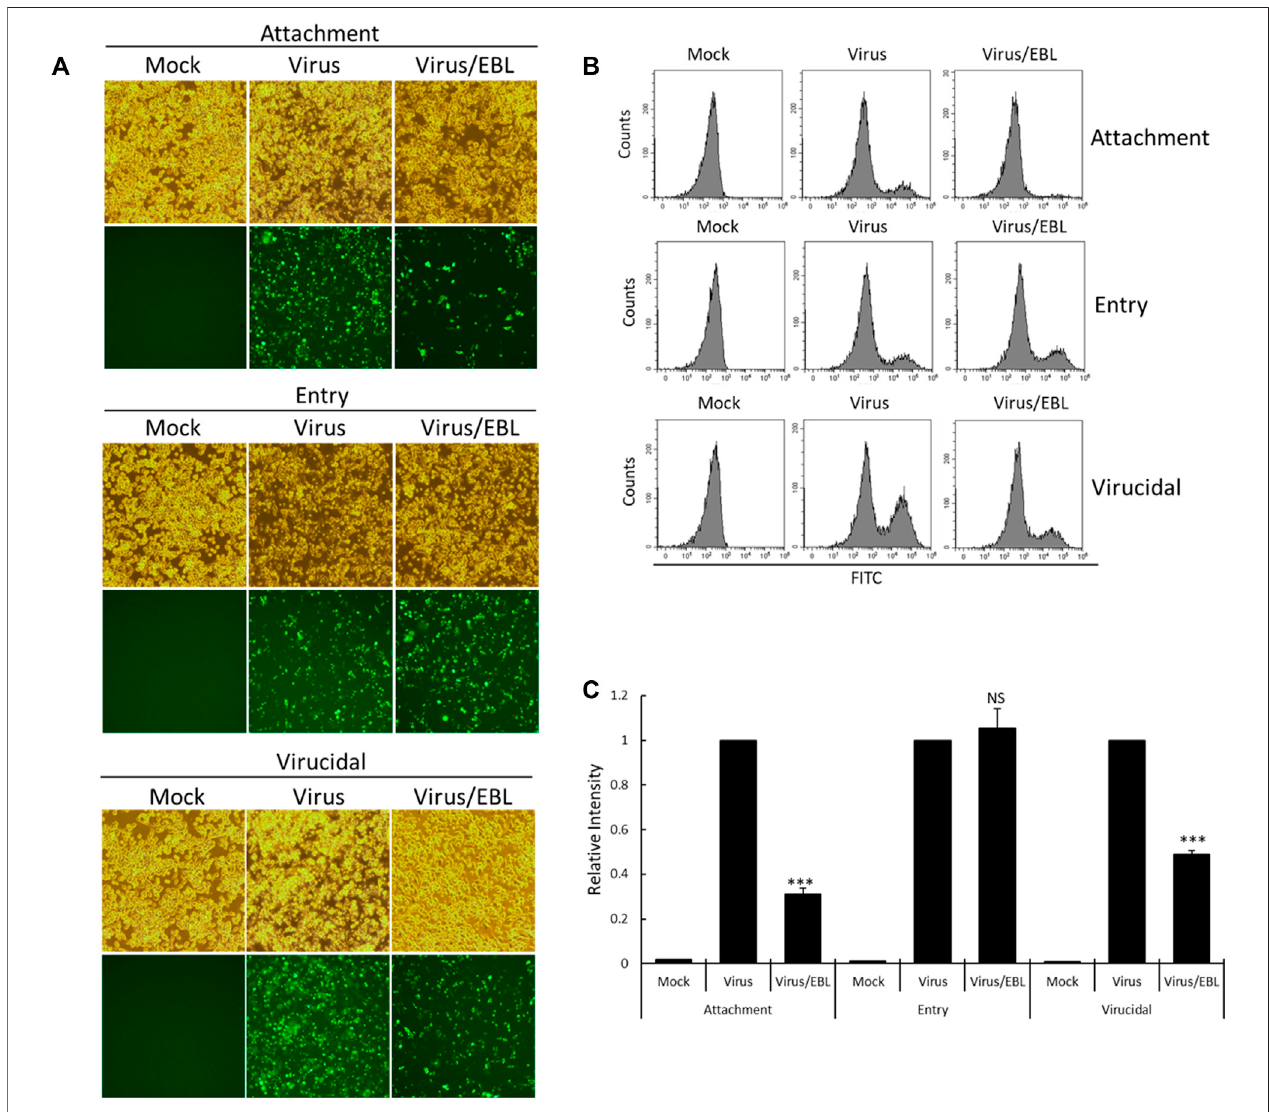
FIGURE4| EBLsuppressesviralattachmentandexertsavirucidaleffect. (A – C) Fortheattachmentstage,RAW264.7cellswerecotreatedwithPR8-GFPIAVand 200 μ g/mlEBLat4 ° Cfor30 min.Afterwashing,thecellswereincubatedat37 ° Cfor24 h.Fortheentrystage,thecellswereinfectedwithPR8-GFPIAVat4 ° Cfor30 min followed by the treatment of EBL at 37 ° C for 30 min. After washing, the cells were incubated at 37 ° C for 24 h. For the virucidal stage, PR8-GFP IAV and EBL were incubated at 4 ° C for 30 min. The mixtures were added to the cells and incubated at 37 ° C for 30 min. After washing, the cells were incubated at 37 ° C for 24 h. (A) Bright fi eld and fl uorescence images of cells were captured under fl uorescence microscopy with ×200 magni fi cation. (B,C) RAW 264.7 cells were fi xed and analyzed by FACS.The GFP-expressing cells weredetected withFITC, and thevaluesofrelative intensitieswere calculated fromcomparison withPR8-GFPIAV.Thedata represent the mean ± SD value based on three independent experiments. Statistical signi fi cance was assessed via an unpaired Student t-test. *** p < 0.0005, NS: No signi fi cance.